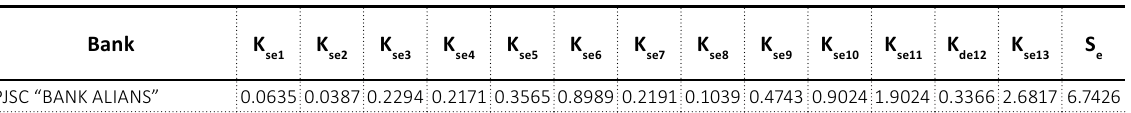
Table 3. Generalized efficiency of